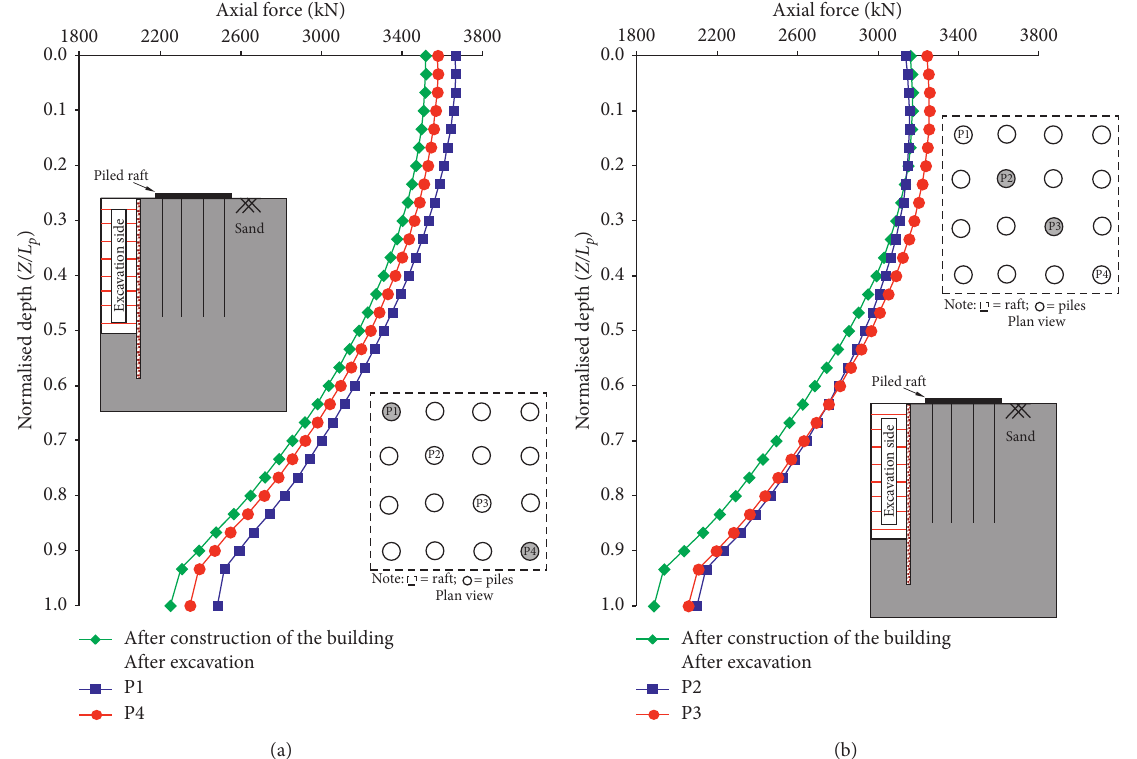
Figure 11: Axial load distribution before and after tunnelling in each case along the lengths of piles. (a) P1 and P4. (b) P2 and P3.